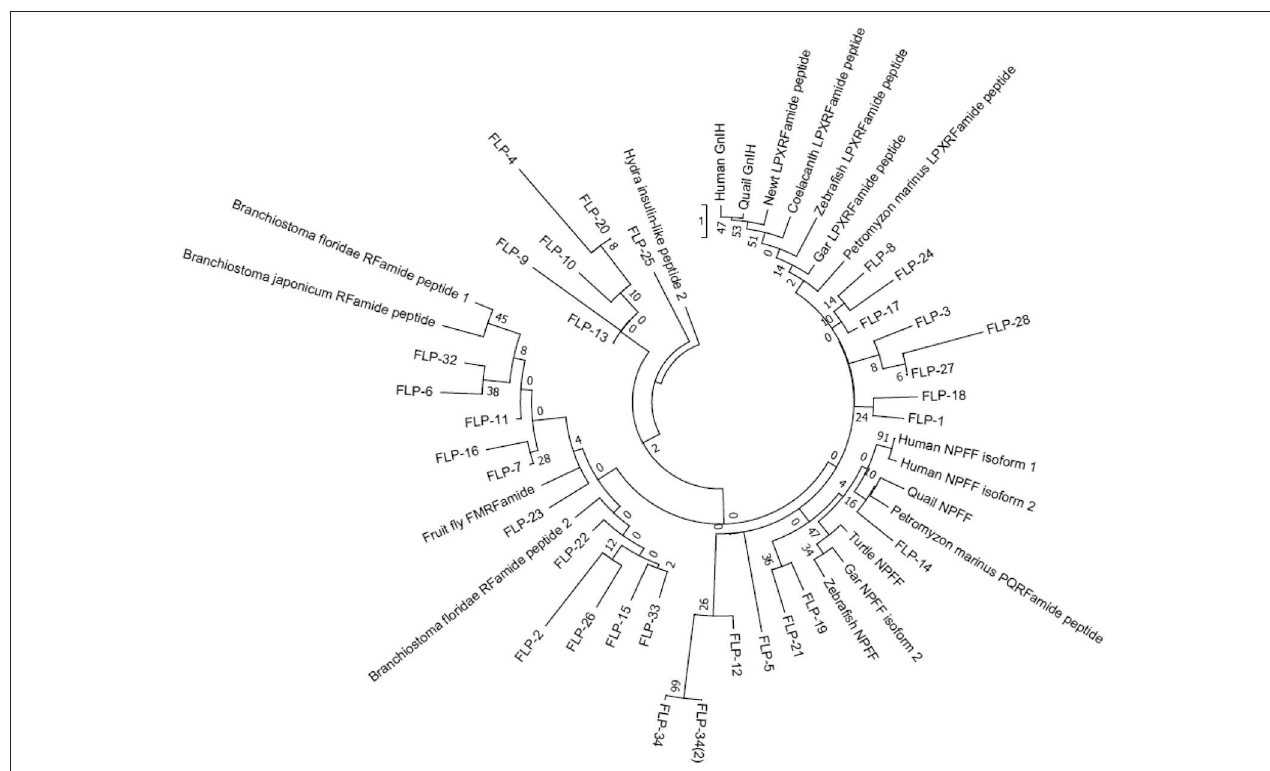
FIGURE 3 | A phylogenetic analysis of human, quail, newt, coelacanth, zebrafish, gar, lamprey, amphioxus GnIH, human, quail, turtle, zebrafish, gar, lamprey, amphioxus NPFF, fruit fly FMRFamide and C. elegans FMRFamide-like peptide (FLP) precursors. Human, quail, newt, coelacanth, zebrafish, gar, lamprey, amphioxus GnIH, human, quail, turtle, zebrafish, gar, lamprey, amphioxus NPFF, fruit fly FMRFamide, and C. elegans FLP precursor polypeptides were aligned by CLUSTALW Multiple Sequence Alignment. Multiple alignment parameters were as follows: Gap open penalty 10, Gap extension penalty 0.2, Protein weight matrix GONNET with residue-specific and hydrophilic penalties. Molecular phylogenetic analysis was performed by Maximum Likelihood method using MEGA7 (Kumar et al., 2016). The Maximum Likelihood method was based on the JTT matrix-based model ( Jones et al., 1992). The tree with the highest log likelihood is shown. Initial tree for the heuristic search were obtained automatically by applying Neighbor-Join and BioNJ algorithms to a matrix of pairwise distances estimated by using a JTT model, and then selecting the topology with superior log likelihood value. The tree is drawn with branch lengths measured in the number of substitutions per site. The analysis involved 51 amino acid sequences. All positions containing gaps and missing data were eliminated. There were a total of 32 positions in the final dataset. The phylogeny was tested by 50 Bootstrap replications. Accession numbers are human ( Homo sapiens ) GnIH precursor (Human GnIH; NP_071433.3), Japanese quail ( Coturnix japonica ) GnIH precursor (Quail GnIH; XP_015709159.1), Japanese fire belly newt ( Cynops pyrrhogaster ) GnIH precursor (Newt LPXRFamide peptide; BAJ78290.1), West Indian Ocean coelacanth ( Latimeria chalumnae ) GnIH precursor (Coelacanth LPXRFamide peptide; XP_005993154.1), zebrafish ( Danio rerio )